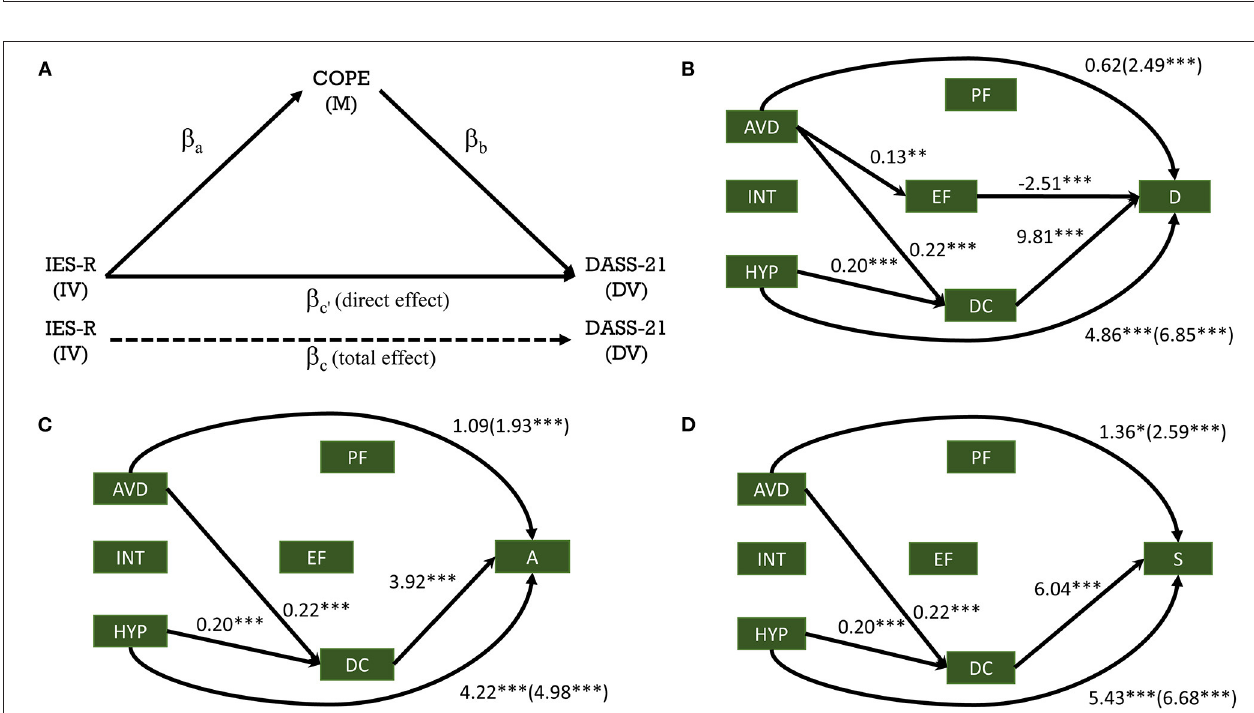
FIGURE 3 | Mediation analysis of the impact of the COVID-19 pandemic on mental health, mediated through coping strategies. Hypothesized mediation model (A) ; Final mediation model for depression (B) , anxiety (C) and stress (D) . DASS-21 : D, depression; A, anxiety; S, stress; IES-R : HYP, hyperarousal; INT, intrusion; AVD, avoidance; COPE : Brief COPE, EF, emotion-focused coping; PF, problem-focused coping; DC, dysfunctional coping. Data represents estimates/betas—direct (total). IV, independent variable; DV, dependent variable; M, mediator. * p < 0.05, ** p < 0.01, *** p < 0.001.